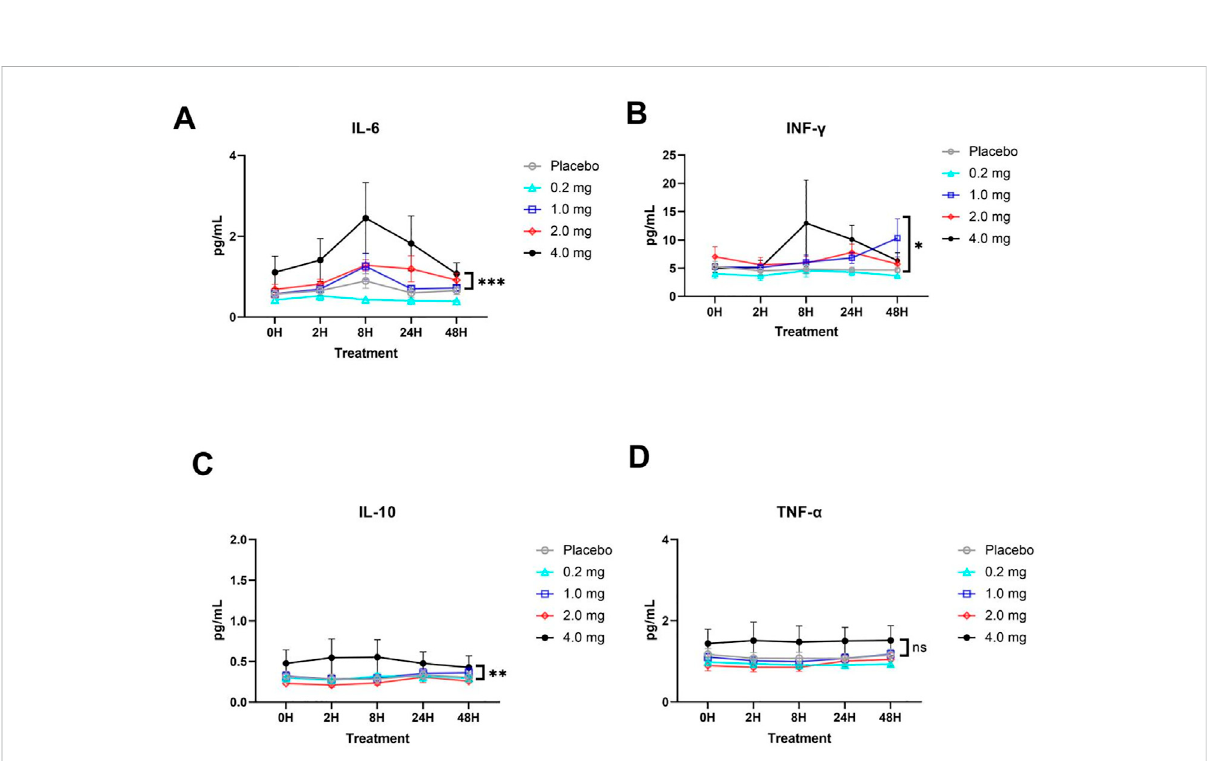
FIGURE 3 Plasma cytokine responses (mean ± SD) in each group. (A) IL-6 cytokine. (B) IFN- γ cytokine. (C) IL-10 cytokine. (D) TNF- α cytokine. The signi fi cant difference analysis was evaluated using two-way ANOVA with Tukey ’ s multiple comparison test (* p < 0.05, ** p < 0.01, *** p < 0.001, ns p > 0.05 non signi fi